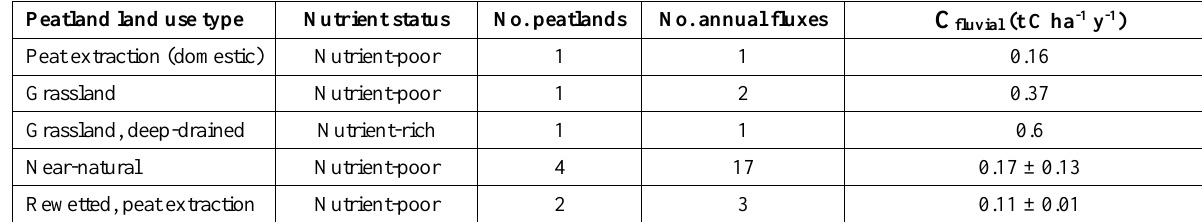
Table 3. Emission factors (EFs) for fluvial (C ) carbon losses (t C ha - ¹ y - ¹) for drained and rewetted fluvial peatlands in Ireland. Standard deviation is given when fluvial losses were measured at > one location.